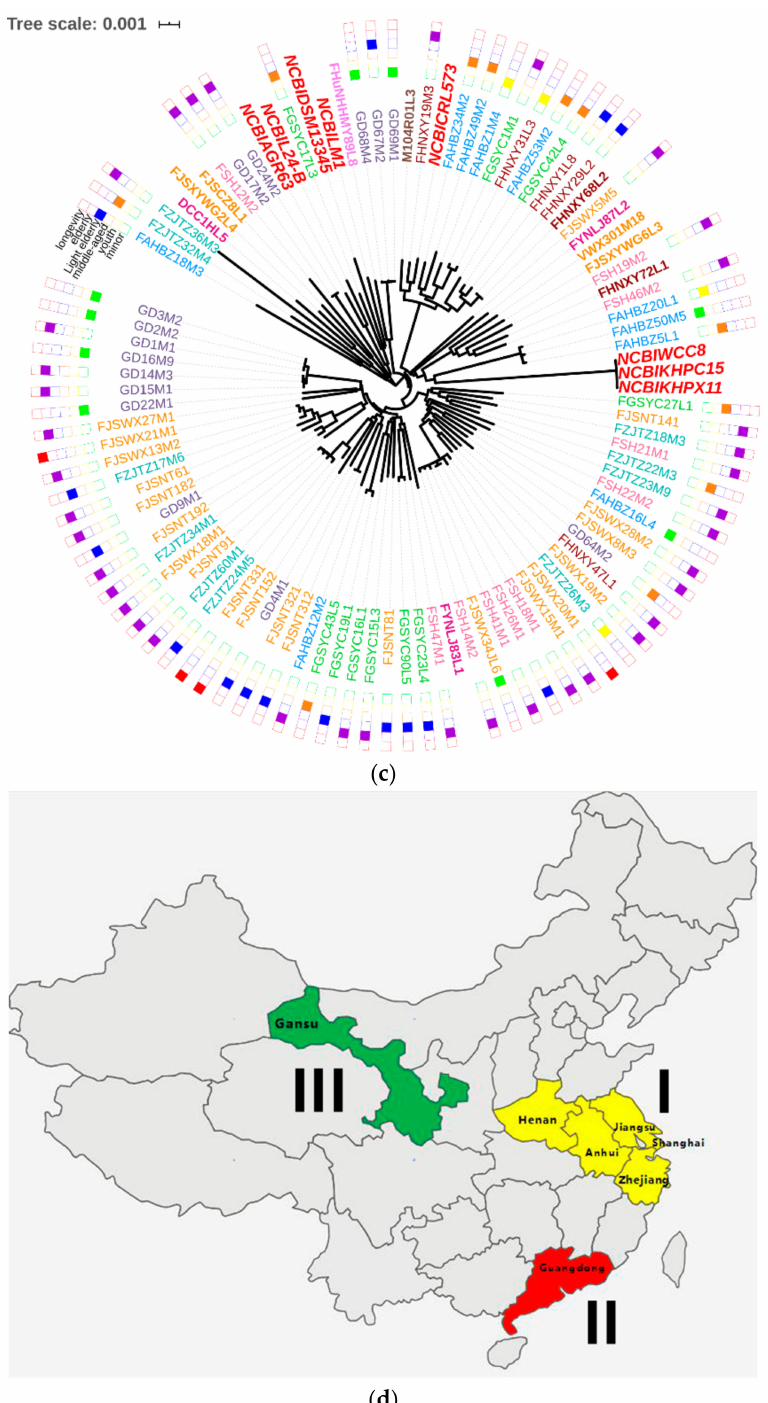
Figure 1. The Average Nucleotide Identity (ANI) and phylogenetic analysis of L. mucosae : ( a ) Heatmap showing the ANI value among 101 L. mucosae strains. Proposed species cut-o ff boundary was around 95% to 96%. ( b ) Venn diagram based on homologous genes. ( c ) Phylogenetic tree based on orthologous genes, taking into account factors, such as distance, age, and habitat. Th di ff erent colored strain numbers represent the strains isolated from di ff erent sampling points. Green, orange, cyan, blue, pink, brown, and purple representing Gansu, Jiangsu, Zhejiang, Anhui, Shanghai, Henan, and Guangdong, respectively. ( d ) Display of the sampling area in the Chinese map. Yellow representing Area I, red representing Area II, and green representing Area